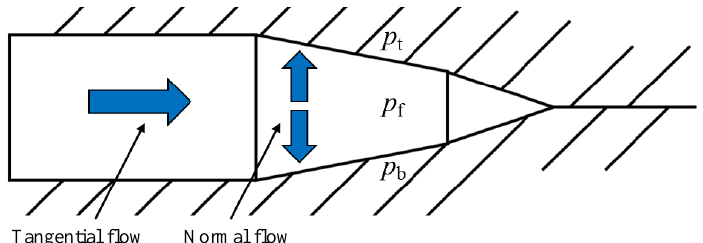
Figure 2. Schematic diagram of fluid flow in crack micro-element.